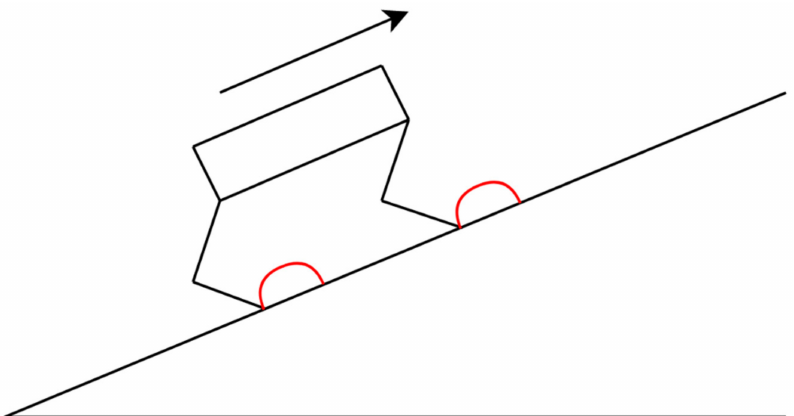
Figure 8. Semi-elliptical